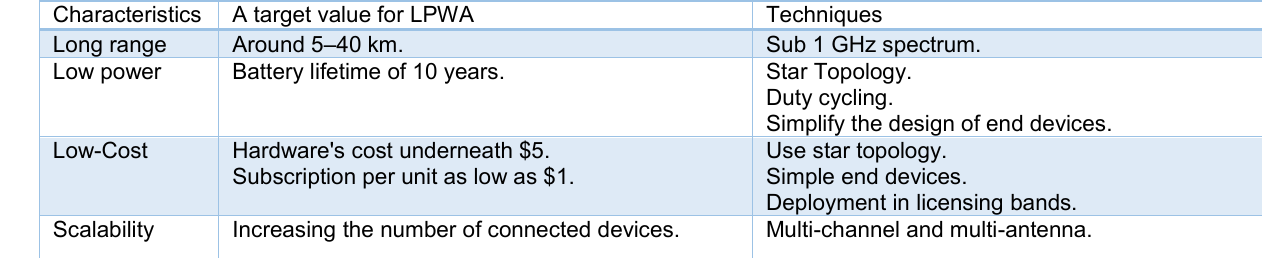
Table 2: LPWA techniques and